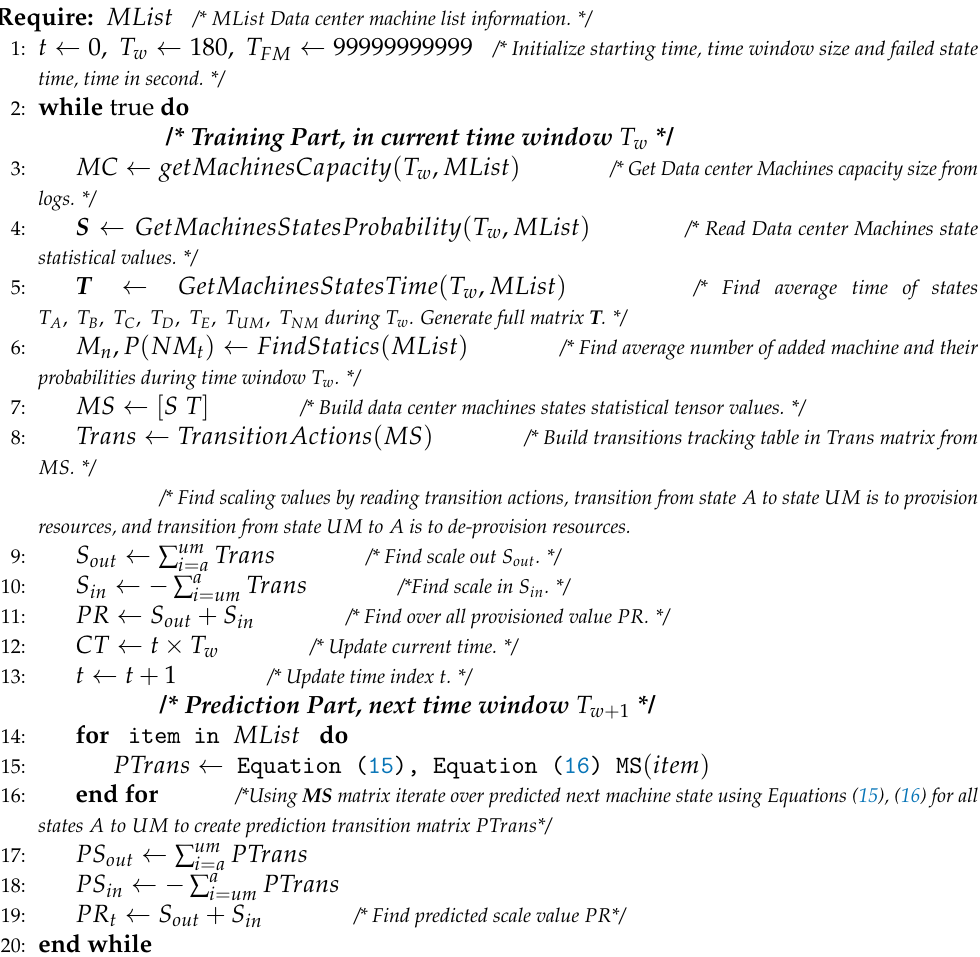
Algorithm 2 Data Center Modeling.